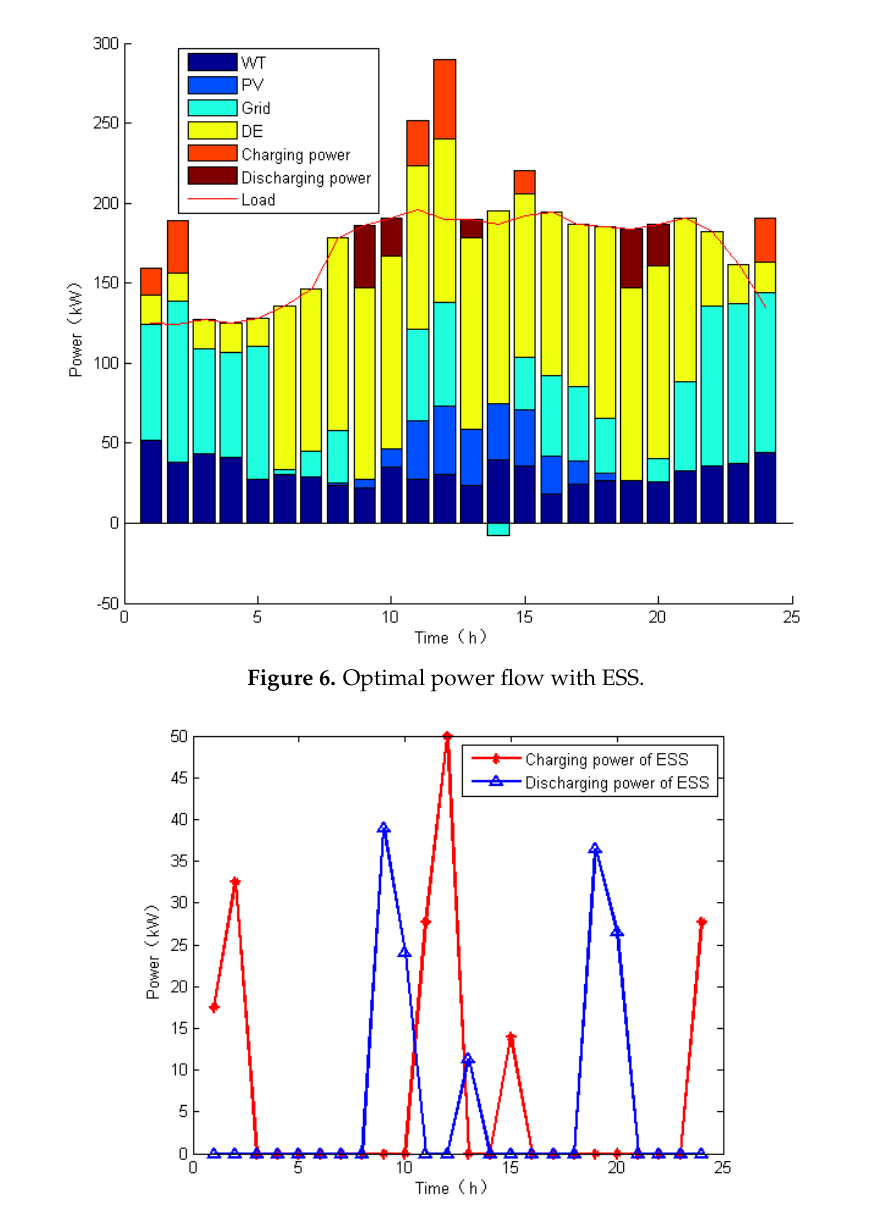
Figure 7. Charging/Discharging power of